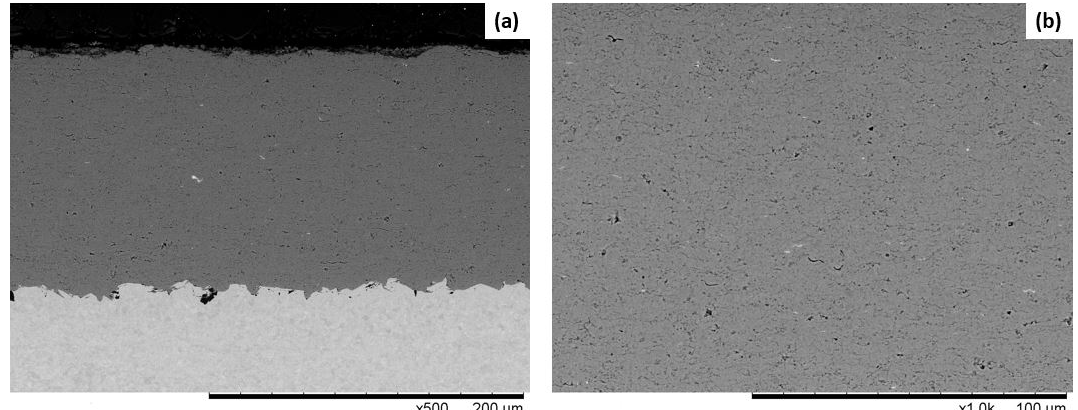
Figure 12. SEM image of cross section of SPS Cr 2 O 3 showing; ( a ) low magnification cross-sectional overview; and ( b ) high magnification microstructure with fine distributed porosity.